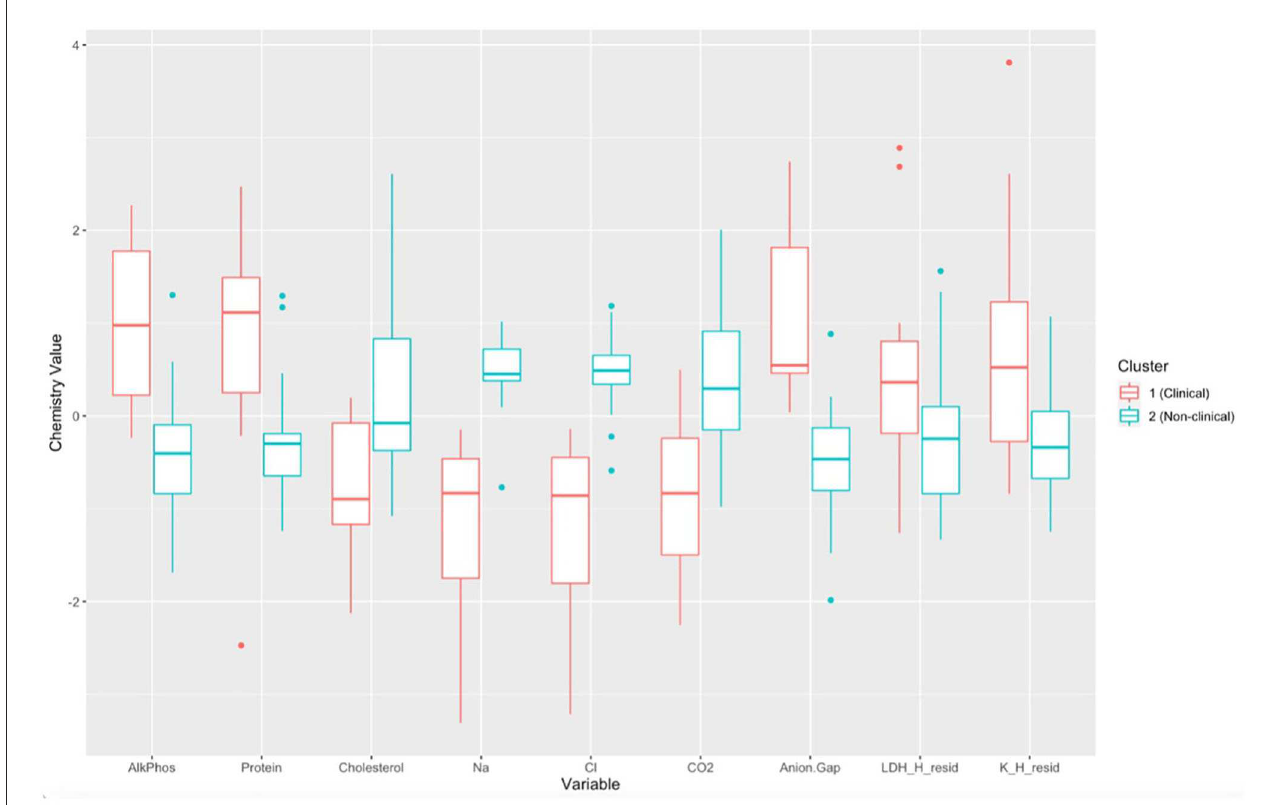
FIGURE5 Boxplots comparing each biochemical variable for cluster 1 ( Batrachochytrium salamandrivorans ( Bsal ) infected, clinically diseased Taricha granulosa ) in red and cluster 2 (control and Bsal -infected, non-clinically diseased T. granulosa ) in blue. Each box represents the interquartile range (IQR), the horizontal line within each box represents the median, vertical lines represent 1.5 * IQR, and dots represent outliers. AlkPhos, Alkaline phosphatase; Na, sodium; Cl, chloride; CO 2 , bicarbonate; LDH_H_resid, the residuals of lactate dehydrogenase (LDH) regressed on hemolytic index (H); K_H_resid, the residuals of potassium (K) regressed on